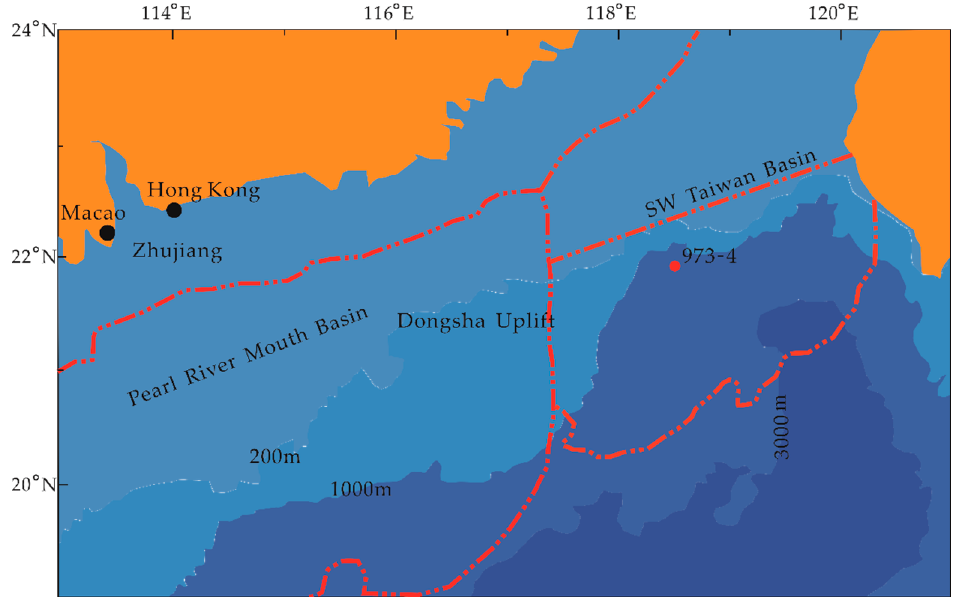
Figure 1. Map showing the locations of the study site 973-4 on the northern slope South China Sea (Modified from Pan et al. [42]).